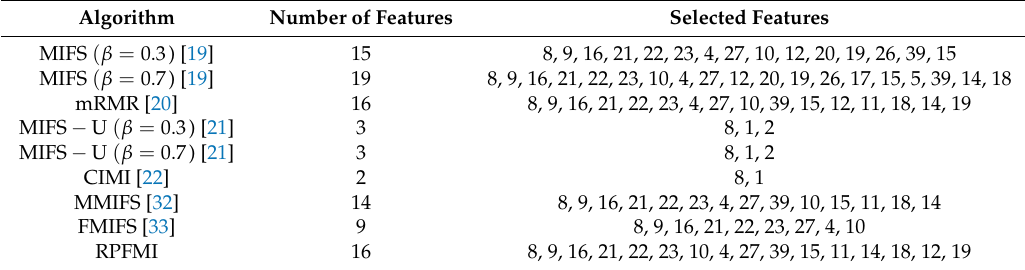
Table 7. Features selected by different feature selection algorithms using the user to root (U2R) classifier.